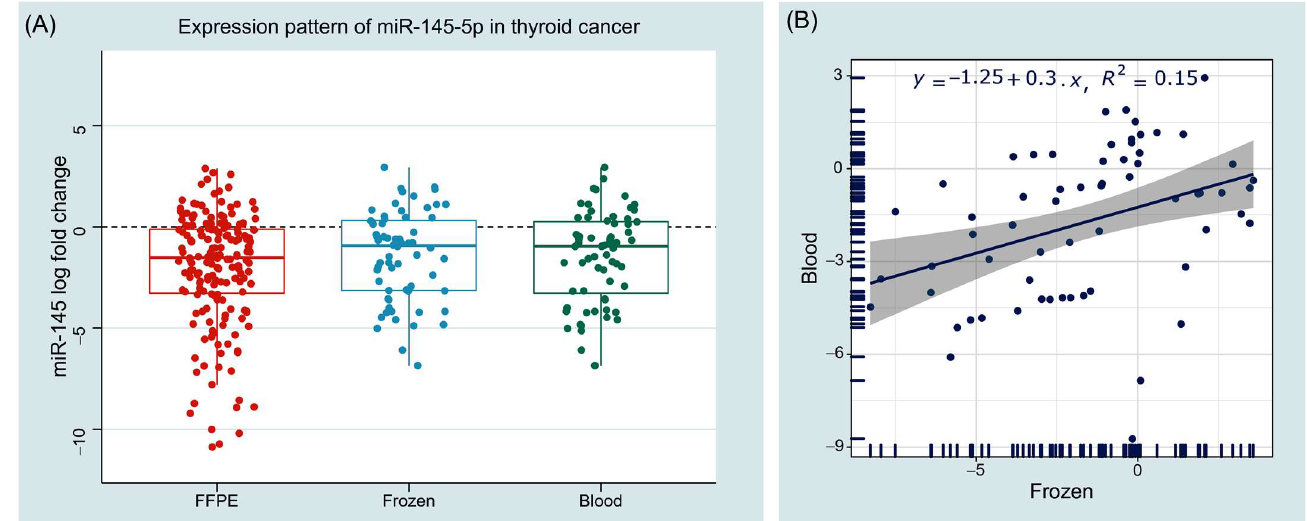
Figure 5. Expression pattern of miR-145 in human tissue and blood samples. ( A ) Boxplots show the log of relative expression levels in cancer samples compared with controls. Wilcoxon matched-pairs signed rank and Mann–Whitney U tests were used. ( B ) Correlation analysis between tissue and blood samples. Spearman’s correlation test was utilized. FFPE: formalin fixed paraffin embedded tissue sections; Frozen: fresh frozen tissues. Table 3. Baseline characteristics of the study population.